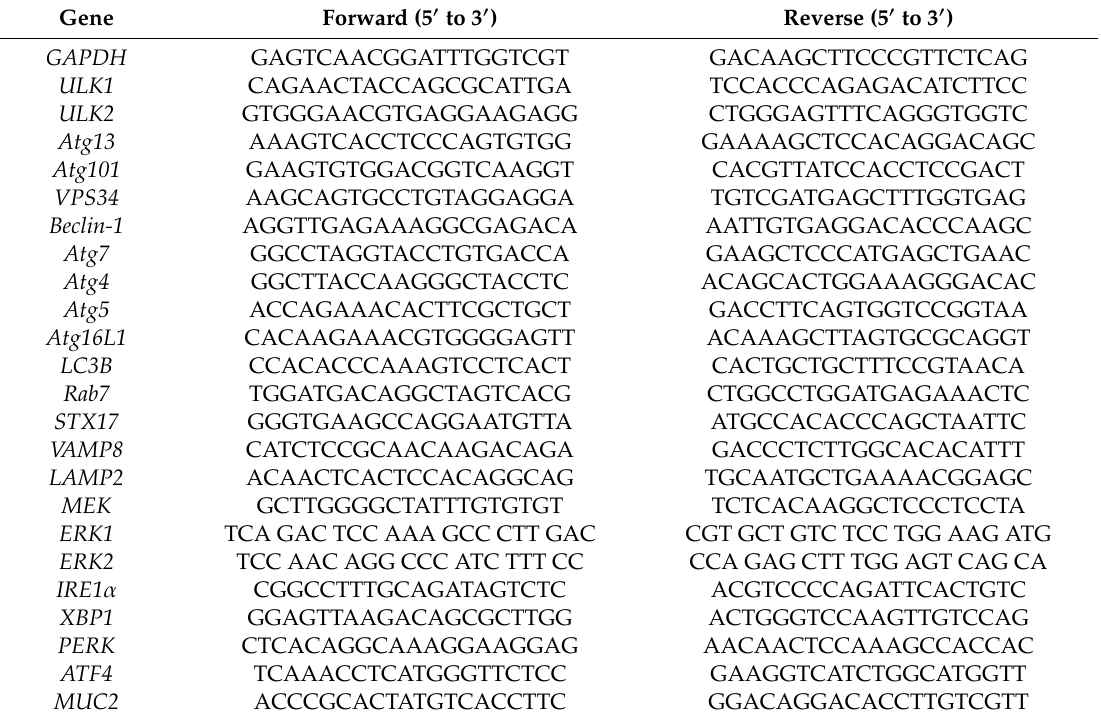
Table 1. Primers used for qPCR